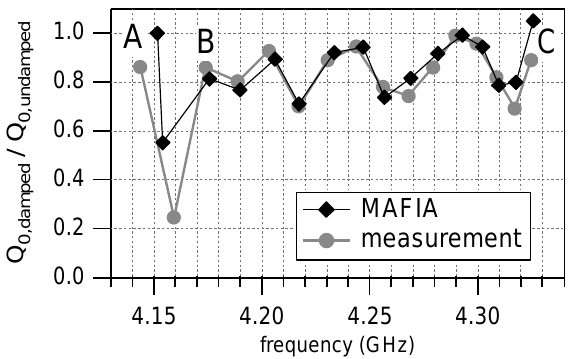
FIG. 14. Comparison of calculated and measured damping effect (reduction of (cid:81) (cid:48)